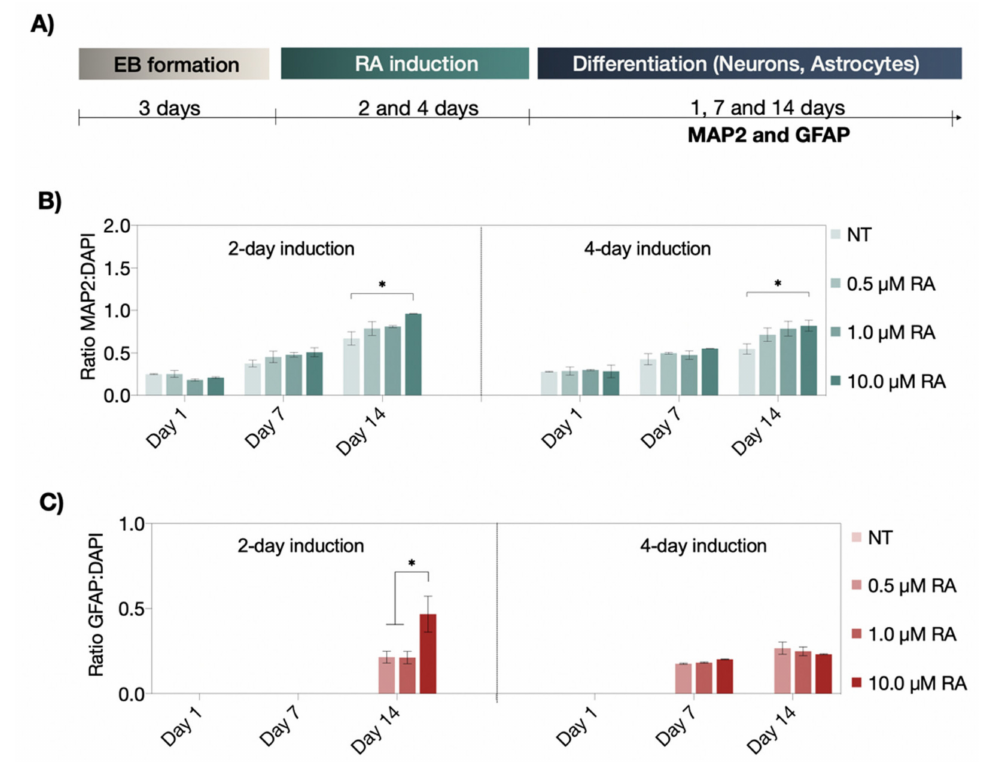
Figure 3. ( A ) Schematic workflow of the neural differentiation protocol of RA-induced neuronal and astrocytic differentiation. ( B , C ) Time-resolved expression of neuronal (MAP2; green fluorescence) and astrocytic (GFAP; red fluorescence) differentiation markers after two- and four-day treatment with concentrations of non-treated (NT), 0.5 µ M, 1.0 µ M, and 10 µ M of RA under static cultivation condition. Statistical significance was tested by using one-way ANOVA (* p < 0.05), n = 2 ± SD. Bars without * do not represent statistical